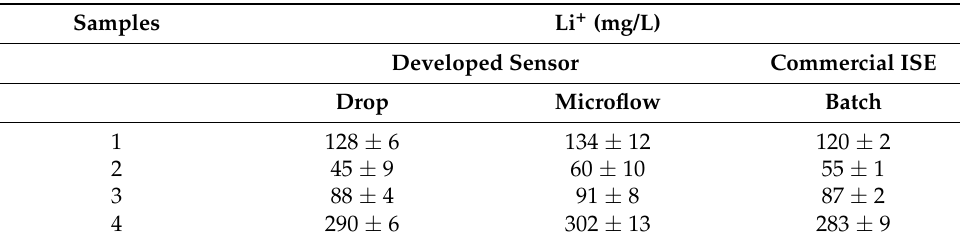
Table 7. Lithium concentrations determined in industrial samples from recycling automotive batteries. Each measurement was repeated at least 3 times using the same sensor. The samples were tested with the developed sensor through both drop measurement and the microflow setup; the results were compared with those obtained in batch with the commercial ISE. Samples Li + (mg/L) Developed Sensor Commercial ISE Drop